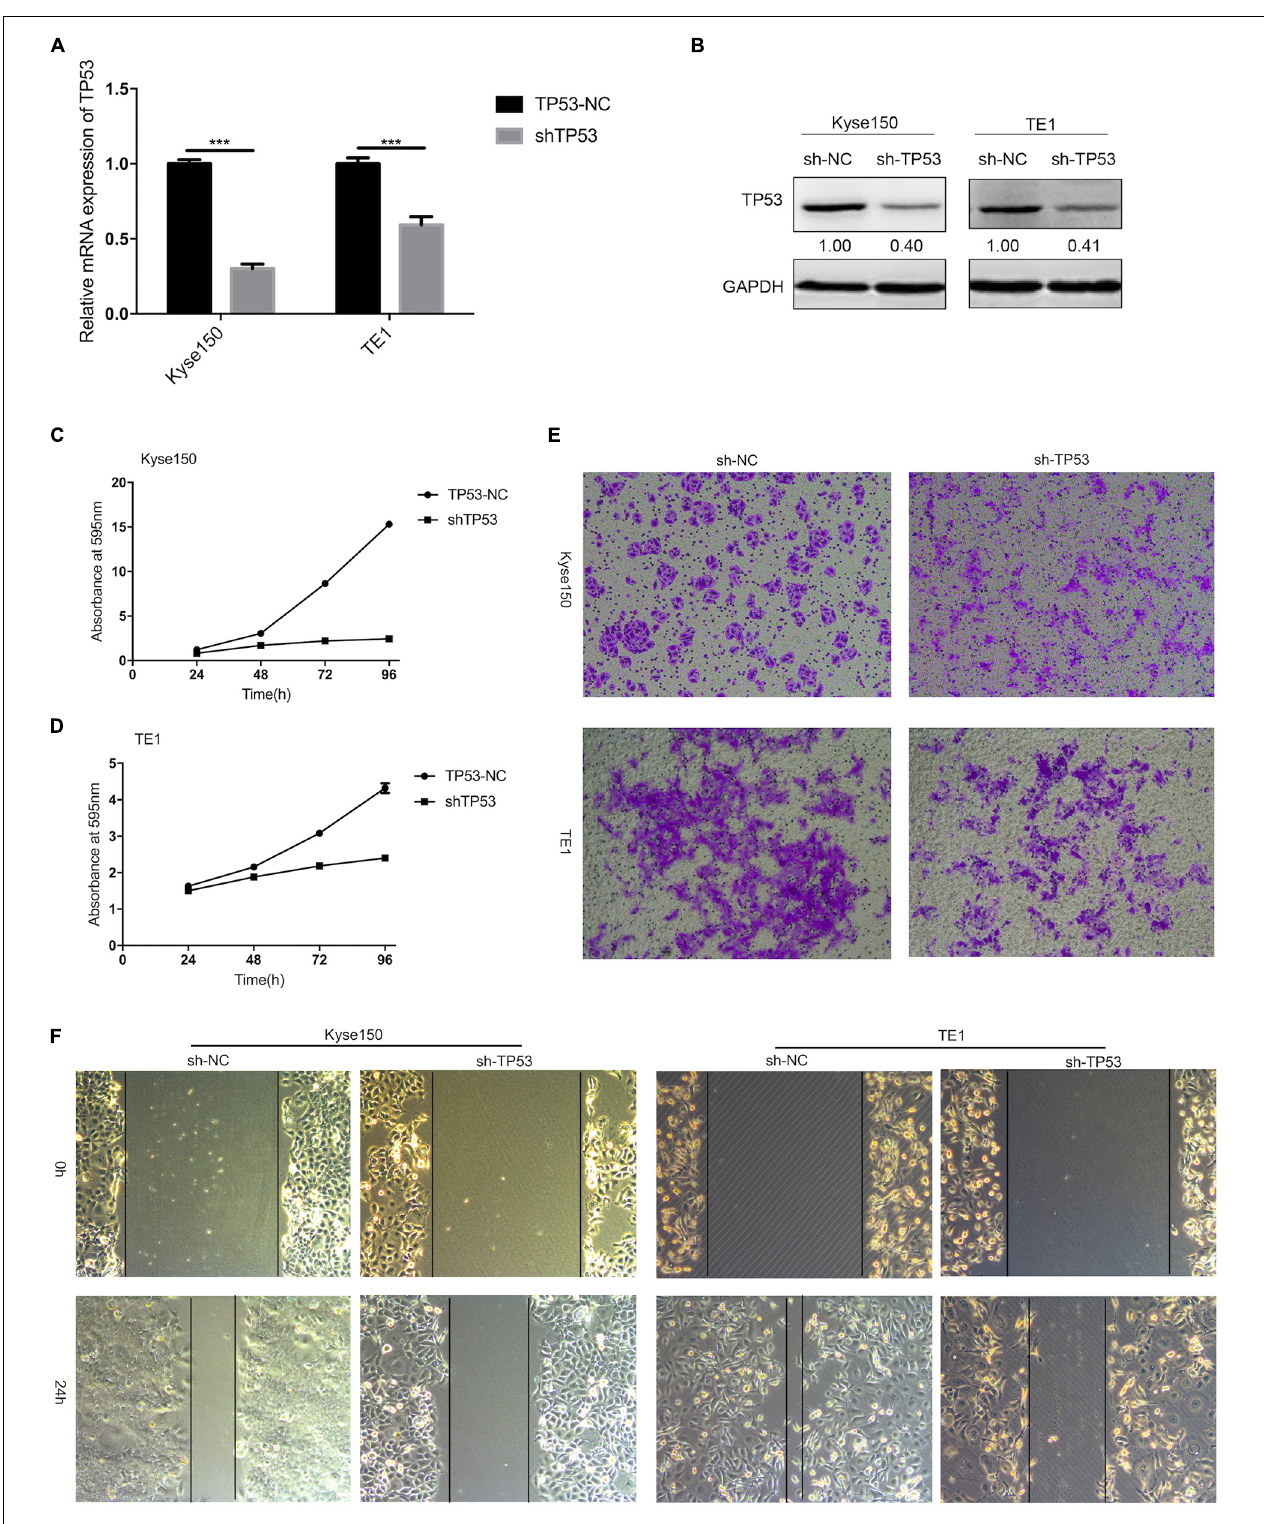
FIGURE 6 | TP53 regulates the proliferation and migration of ESCC cells. KYSE-150 and TE1 cells were stably transfected with plasmids (sh-NC and sh- TP53 ). The mRNA expression and protein expression of TP53 were determined by qRT-PCR and Western blotting (A,B) . Crystal violet assay demonstrated that knockdown of TP53 significantly inhibited cell proliferation (C,D) . Transwell and Scratch test showed downregulated expression of TP53 decreased cell migration (E,F) . Data are presented as mean ± SD; *** indicates p < 0.001.